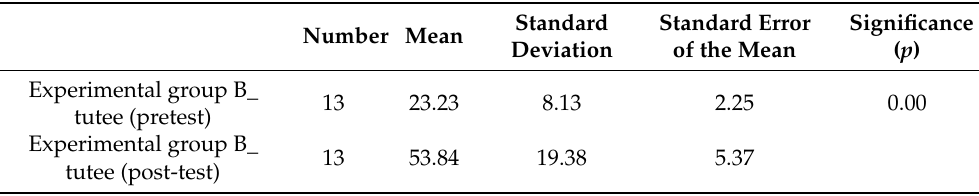
Table 8. Pretest and post-test t -test analyses of Experimental group B_tutee.